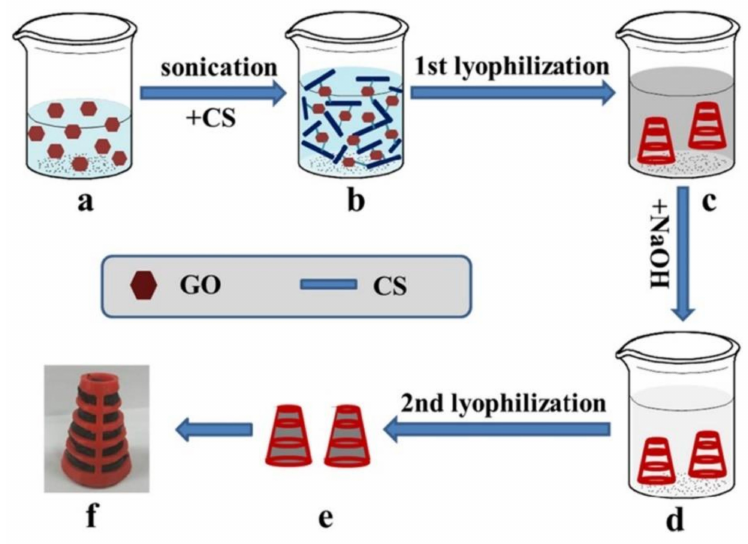
Figure 26. Schematic description of the fabrication process of the PLA-GO-CS composite ( a ) GO aqueous solution. ( b ) The mixture of CS and GO solution. ( c ) PLA scaffold was put into the mixture along with the first lyophilization. ( d ) PLA-GO-CS immersed in the sodium hydroxide solution (10%). ( e ) PLA-GO-CS after the second lyophilization. ( f ) The digital photo of the real PLA-GO-CS scaffold (Reproduced with permission from Reference [181], copyright 2018,